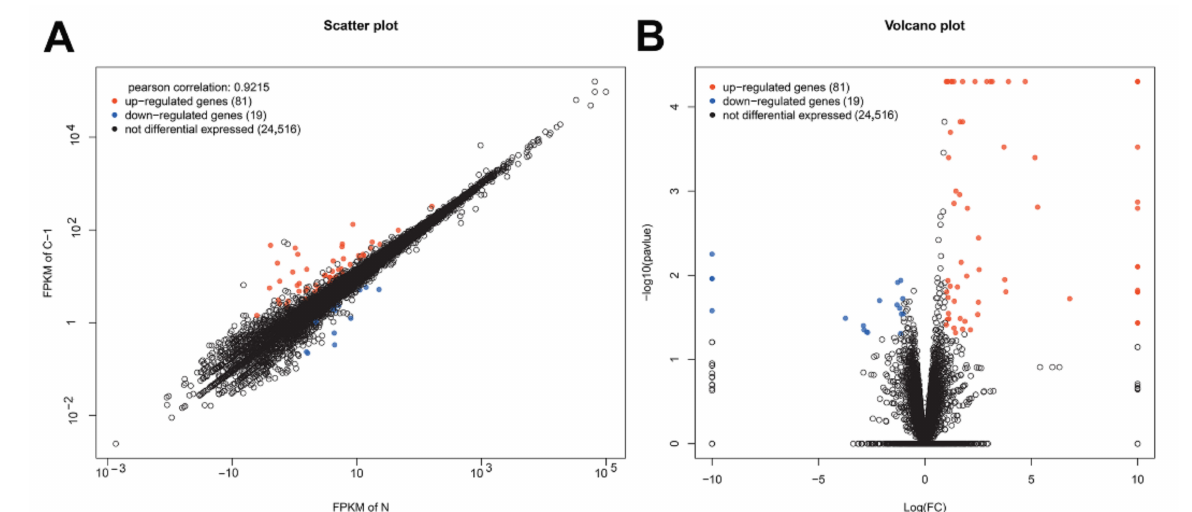
Figure 1. Summary of the differentially expressed genes between Caprine herpesvirus 1 (CpHV-1)-infected and mock- infected samples at 12 hours post infection (hpi). A is a scatter-plot. The abscissa and ordinate coordinates represent the expression of genes or transcripts in two samples, respectively. Pearson correlation refers to the correlation index of gene expression levels of two samples. Red points represent up-regulated genes, blue points represent down-regulated genes, and black circles represent genes showing no significant differences in expression. B is a volcano-plot. The abscissa means the logarithm of the multiple difference of the expression of genes in the two samples; the larger the absolute value, the greater the difference in gene expression. The ordinate means the negative logarithm of the statistical significance of the expression of gene; the larger the value, the more significant the differential expression and the more reliable the differential gene. Red points represent up-regulated genes, blue points represent down-regulated genes, and black circles represent genes showing no significant differences in